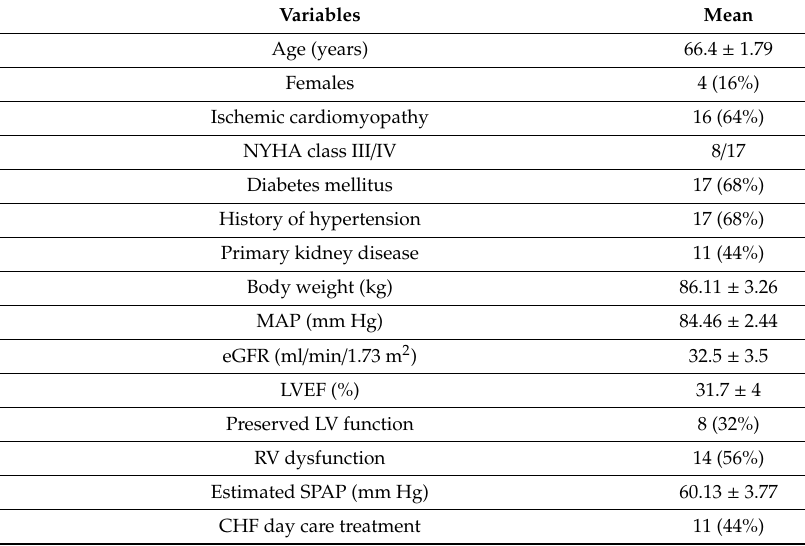
Table 1. Selected clinical, biochemical, and echocardiographic characteristics of the patients at